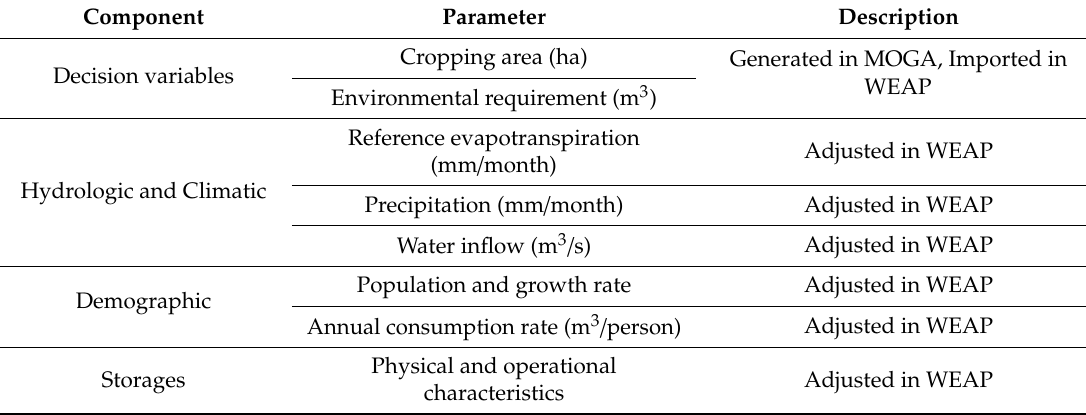
Table 3. Implementation of model components and flows in